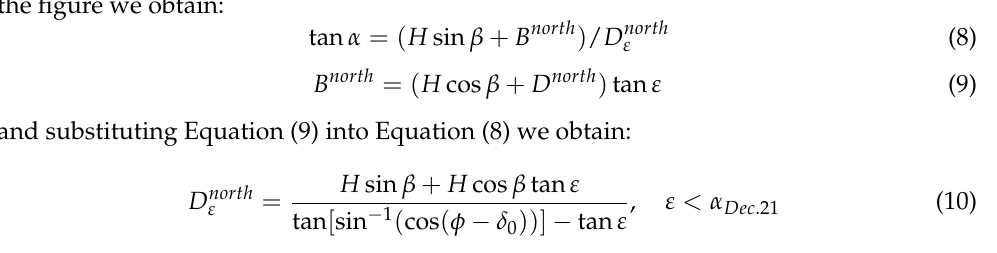
north = D h H sin β + B > D h . H sin β